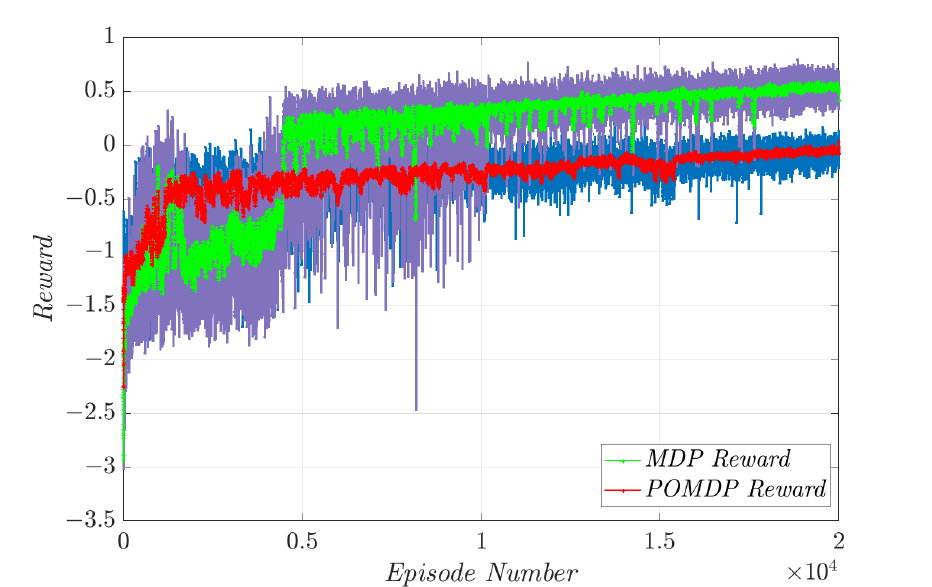
Figure 4. MDP and POMDP rewards over 20,000 episodes.